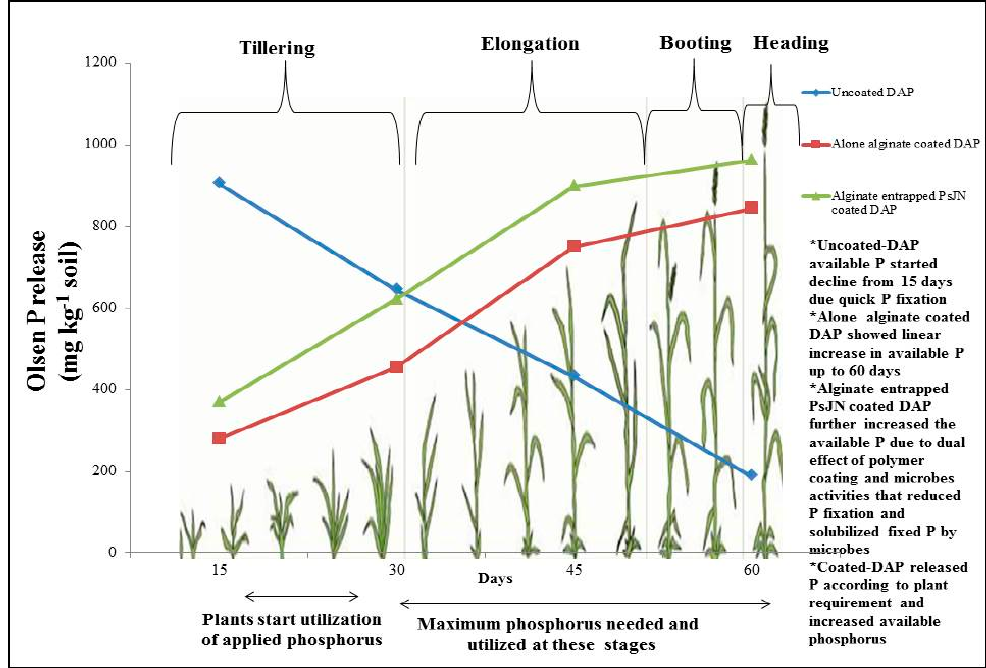
Figure 4. The phosphorus release in soil from alginate coated and uncoated DAP fertilizer over different time intervals and growth stages of wheat.